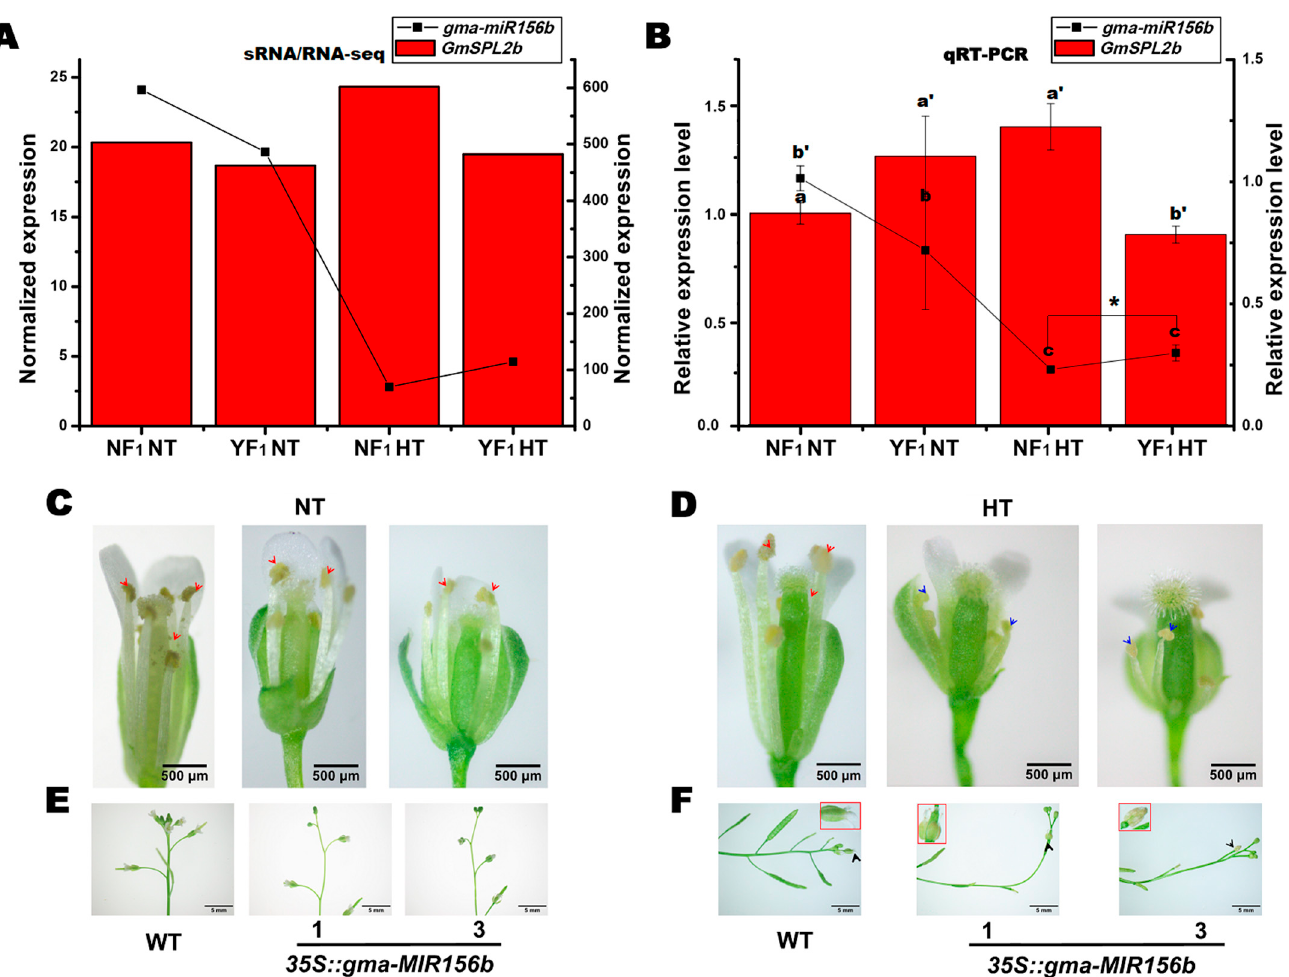
Figure 5. Effect of long-term moderate HT on male fertility in wild-type (WT) and 35S::gma-MIR156b lines of Arabidopsis. ( A , B ) Expression levels of gma-miR156b and its target GmSPL2b in sRNA/RNA sequencing and qRT-PCR analysis. Data are presented as means ± SD from three independent biological replicates. Values with a different letter indicate statistical differences (one-way ANOVA, Duncan’s test, p < 0.05). Student’s t -test was performed to compare the gma-miR156b expression difference between NF 1 HT and YF 1 HT. Asterisk indicates statistical differences, * p < 0.05. The left and right y -axes are the expression level scales for GmSPL2b and gma-miR156b , respectively. ( C , D ) Phenotype of anthers in WT and 35S::gma-MIR156b lines under long-term moderate HT condition. The red and blue arrows indicate dehiscent and indehiscent anthers, respectively. Scale bars = 500 µ m. ( E , F ) Phenotype of inflorescence in WT and 35S::gma-MIR156b lines under long-term moderate HT condition. The black arrow indicates yellowed and wilted flower under moderate HT condition. The flower in the red box in the upper-right/left corner is a magnified view of the flower pointed by the black arrow. Scale bars = 5